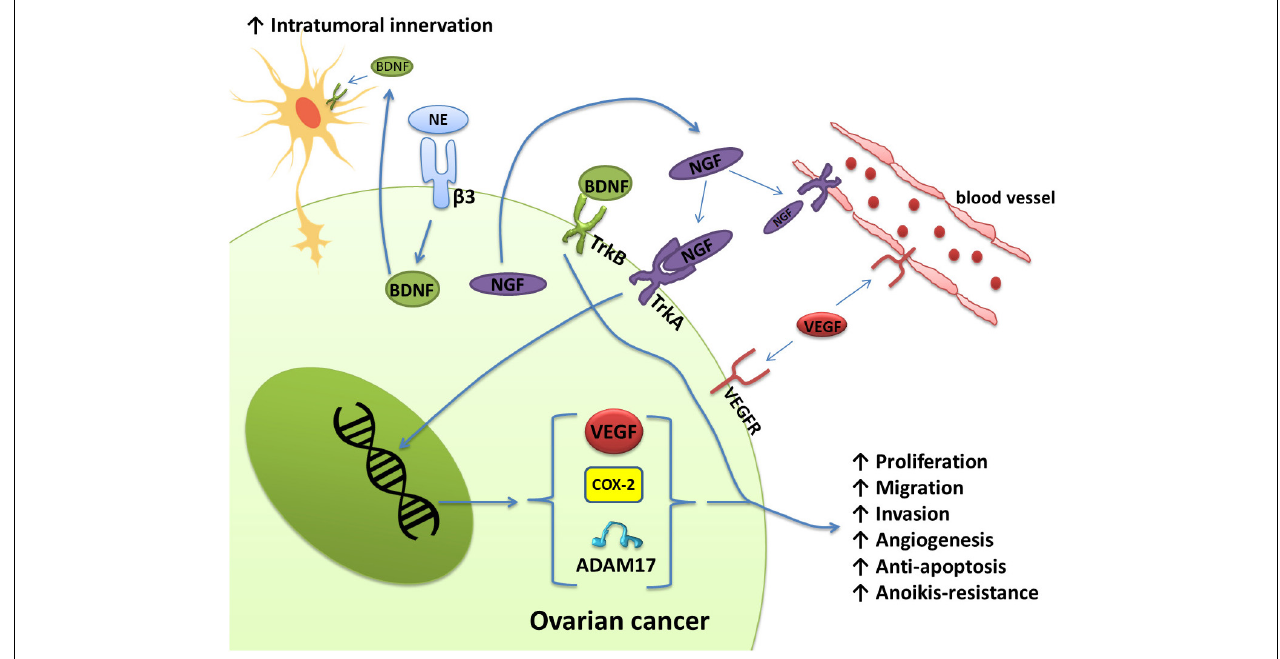
FIGURE 2 | Schematic representation of the effects of NGF/TrkA and BDNF/TrkB, which are involved in several signaling pathways in ovarian cancer. Ovarian cancer cells express and secrete NGF. Through the activation of TrKA, NGF induces angiogenesis by directly stimulating the proliferation of endothelial cells. Nerve growth factor also regulates angiogenesis indirectly through the production of VEGF by ovarian cancer cells. In addition, NGF increases COX-2 levels, which induces the production of PGE-2. PGE-2 has been associated with invasion in cancer cells. ADAM17 also appears to be regulated by the activation of NGF/TrkA. Activation of the BDNF/TrkB pathway also confers migration, invasion, angiogenesis, and anoikis resistance to ovarian cancer cells. Norepinephrine can also bind to ADRB3 expressed by ovarian cancer cells to induce the production of BDNF, which then acts on TrkB receptors on nerve cells to increase the innervation of tumor tissues.